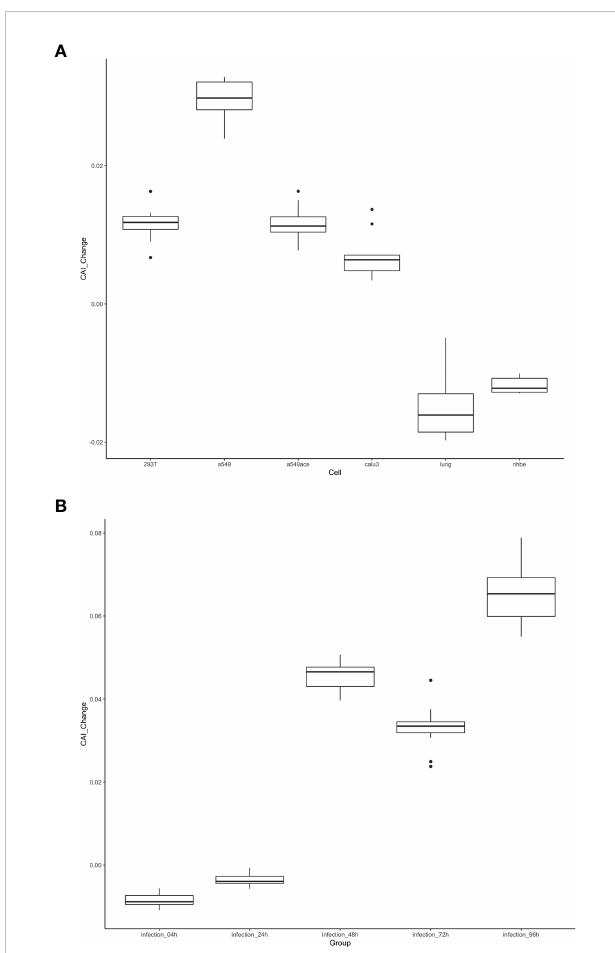
FIGURE 14 The distribution of the change of CAI values of the SARS-CoV-2 reference genome in different cell datasets shown by box plot. CAI_Change is calculated by CAI in infected cells minus CAI in control cells. (A) Each box shows the CAI_Change distribution of all ORFs in a speci fi c cell type (293T, a549, a549ace, calu3, lung, nhbe). (B) Each box shows the CAI_Change distribution of all ORFs in infected HBEC cells with different times after infection. The control cells are cultured for 4